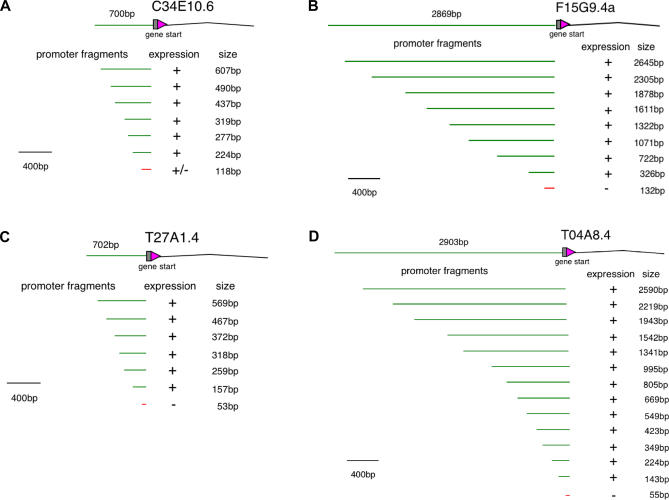
Serial Deletions Series for the Promoter Regions Used To Determine the Minimal Sequence Required to Drive GFP Expression in Muscle(A) C34E10.6 promoter length 700–118 bp drives expression in muscle and neural tissue.(B) F15G9.4a promoter length 2,869–326 bp drives expression in body wall muscle; at 132 bp, all expression was lost.(C) T27A1.4 promoter length 702–157 bp drives expression only in muscle; at 53 bp, all expression was lost.(D) T04A8.4 promoter length 2,903–995 bp drives expression in pharyngeal, vulval, and body wall muscles; promoter length 805–143 bp fails to drive expression in pharyngeal muscle; at 55 bp, all muscle had lost expression.